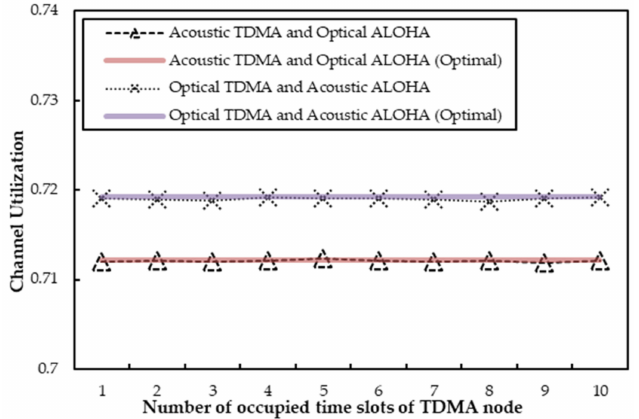
Figure 8. Channel utilization when one agent coexists with one ALOHA node and one TDMA node, which have fixed q and variable R